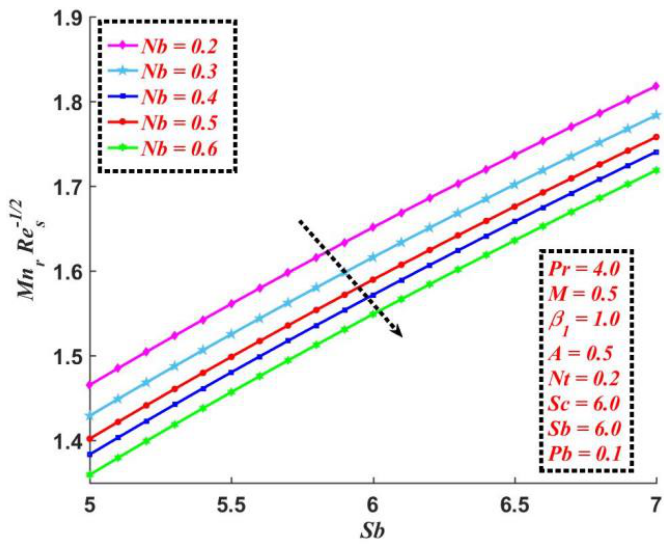
Figure 15. Variation of the motile microorganisms’ number with 𝑁𝑏 and 𝑆𝑏 .